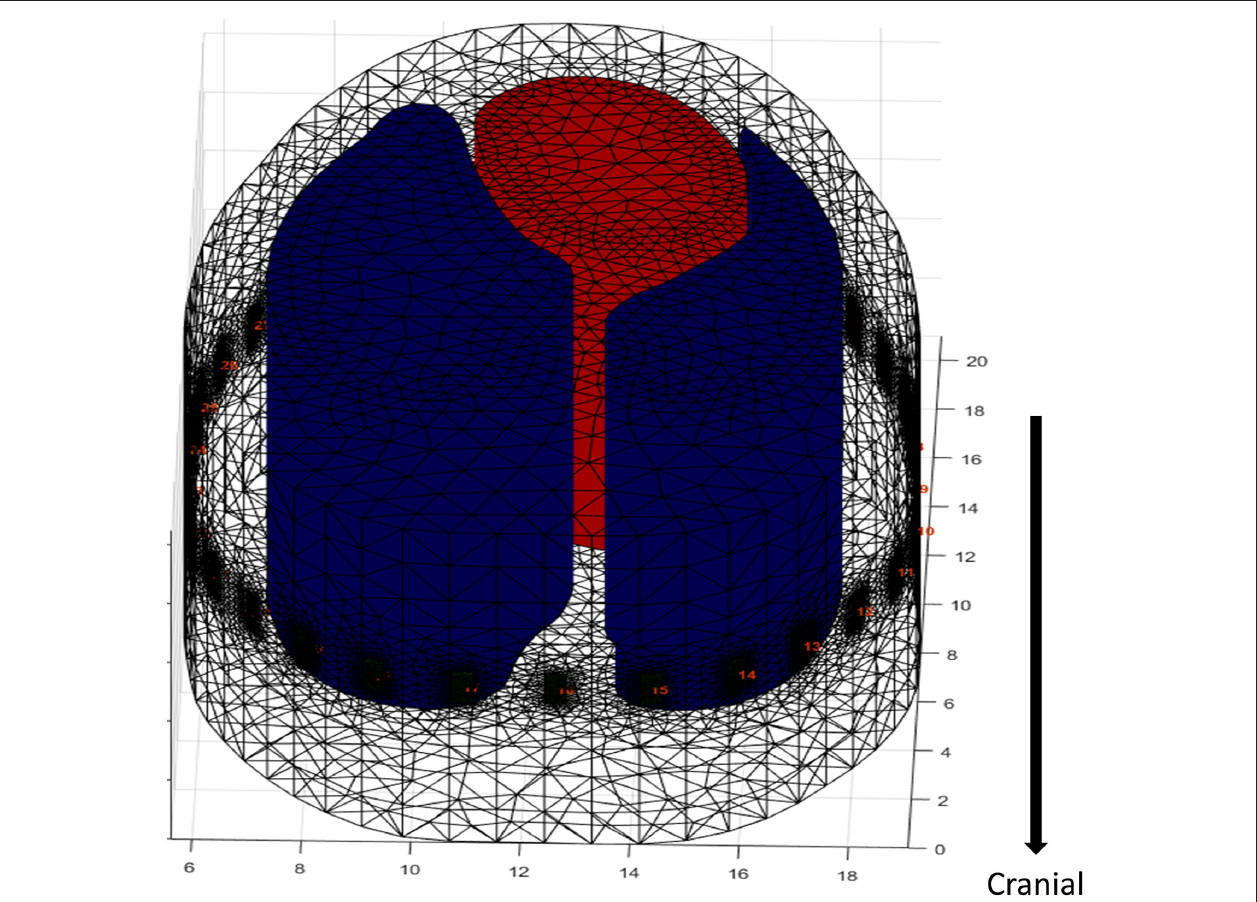
FIGURE 3 | Extrapolation of an FE model in a dog. The electrodes are artificially placed into the model around the contour at the level of the 5–6th intercostal space. The cranial and caudal direction does not account for anatomic changes in ROI contour, as it is taken from a single CT slice resulting in no variation in the diameter of the lung model. A 2-D FE model would miss data capture as EIT does not measure a single plane but captures data in an ellipse reducing in sensitivity as distance from the electrode plane increases, hence the need for increased depth of the FE model. However, with the lack of variation in diameter there is potential of artefactual data (black dots = electrodes, red = heart, blue =